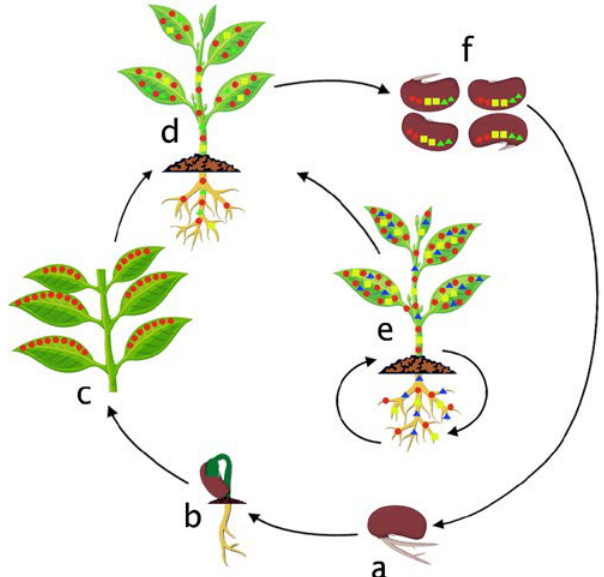
Figure 1. Hypothesized colonization cycle of bacterial endophytes in the host plant. ( a ) Mobilization of seed endophytes in germinating seedlings. ( b ) Recruitment of alien endophytes from the soil in developing seedlings. ( c ) Colonization by alien and inherited endophytes. ( d ) Whole plant colonization by various endophytes. ( e ) Variation of endophyte communities in the host plant in response to different biotic and abiotic stresses. ( f ) Vertical transfer of endophytes into seeds.